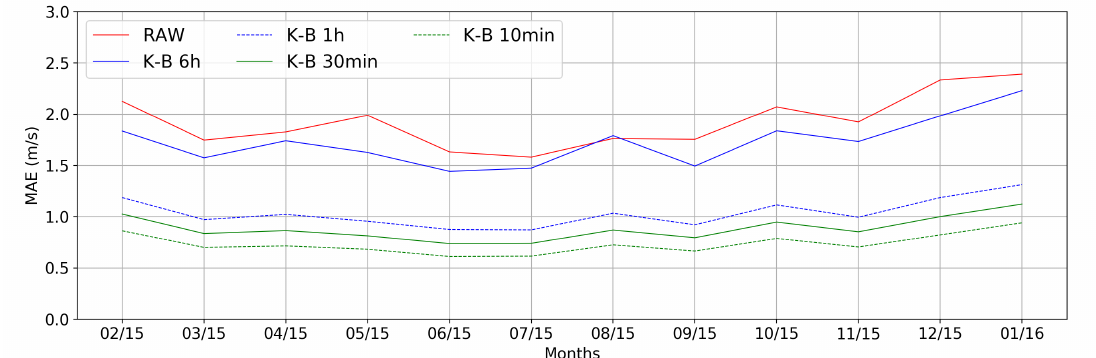
Figure 4. Monthly wind speed MAE for the wind turbines with K-B model (6 h (blue), 1 h (dotted blue), 30 min (green), and 10 min (dotted green)) and RAW (red).